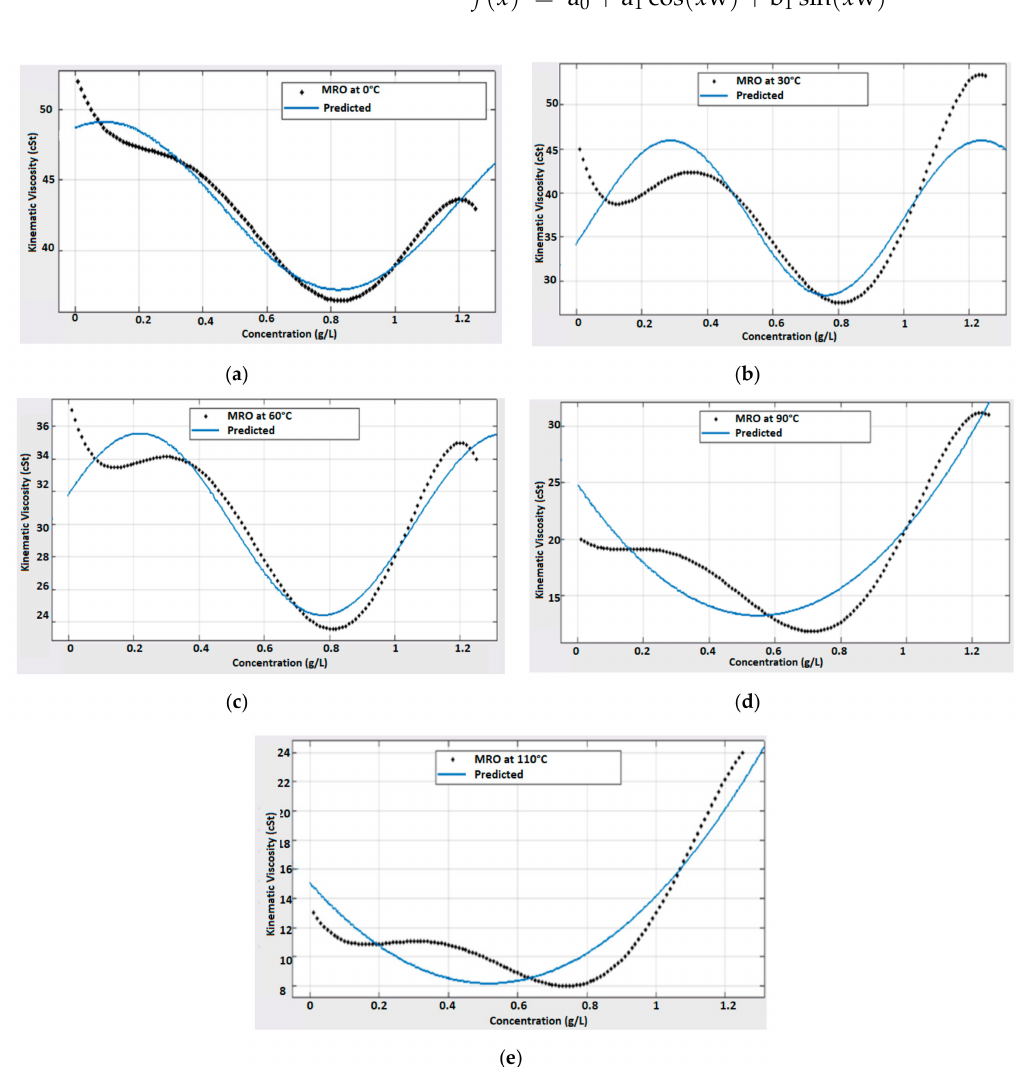
Figure 11. Comparison of measured and predicted kinematic viscosity of MRO using Lagrange polynomial interpolation function and Fourier distribution function. The predicted value showing deviation of ± 2 cSt and 0.6 ± 0.2 g/L from the measured value, ( a ) at 0 ◦ C, ( b ) 30 ◦ C, ( c ) 60 ◦ C, ( d ) 90 ◦ C, ( e ) 110 ◦